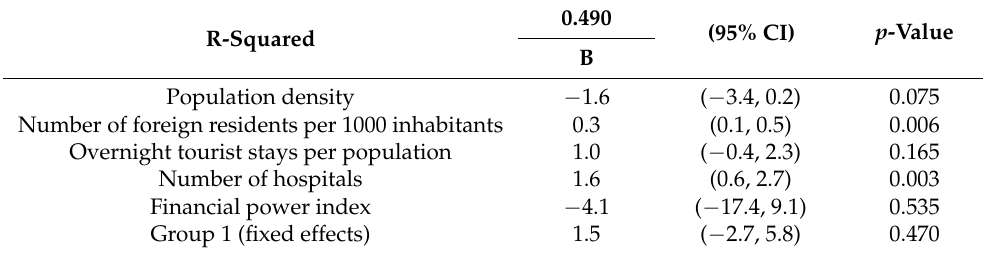
Table 3. Factors associated with health care information